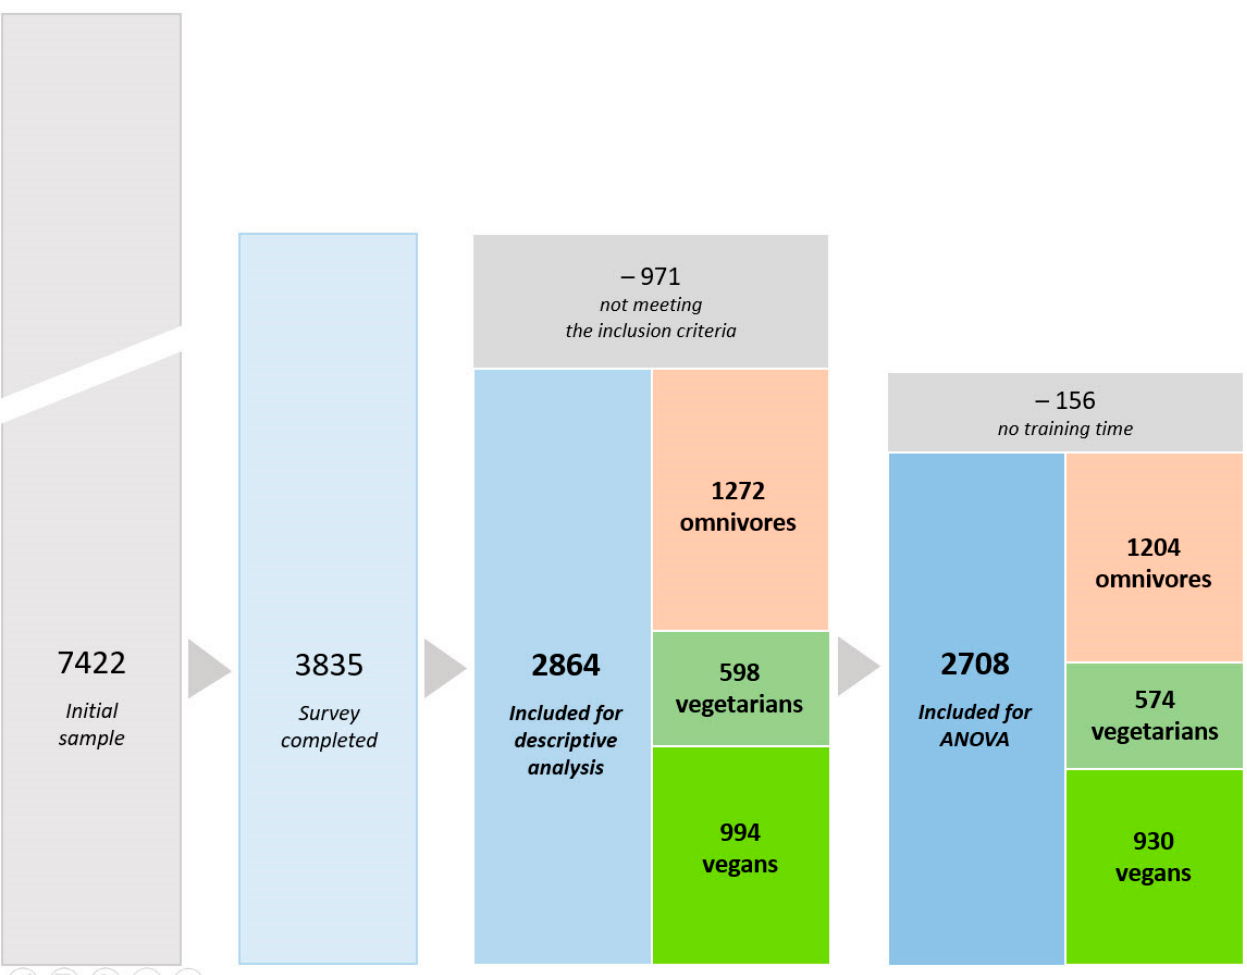
Figure 1. Flow of participants’ enrollment and dietary subgroups. Omnivores—have no restriction on source of food; Vegetarians—avoid all flesh foods but consume egg and/or dairy products; Vegans—avoid all foods and ingredients from animal